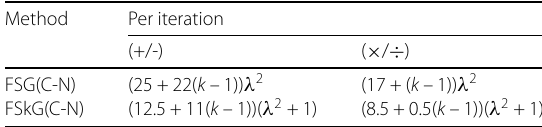
Table 1 Computational complexity analysis for FSG(C-N) and FSkG(C-N) methods before convergence